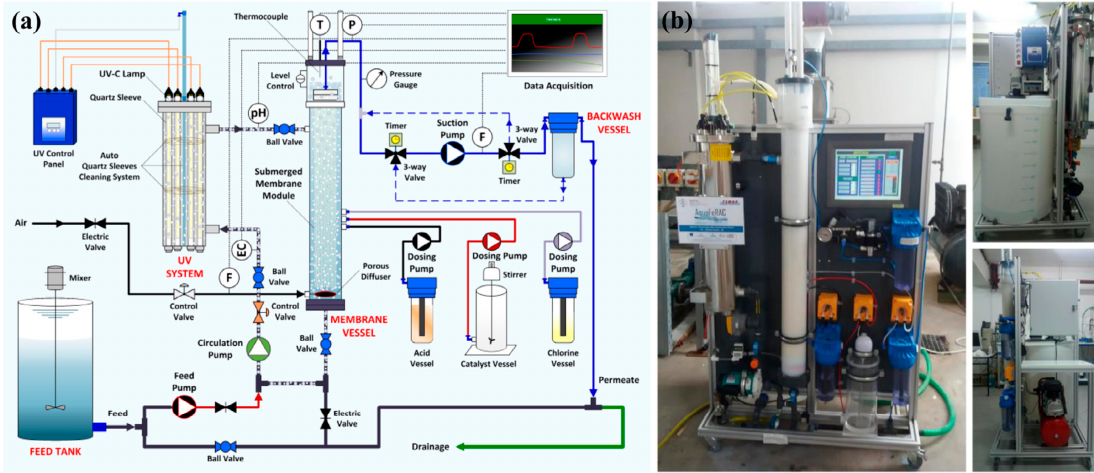
Figure 9. ( a ) Schematic diagram and ( b ) front and side views of the pilot scale continuous PMR system. Adapted with permission from [70], Copyright Elsevier,